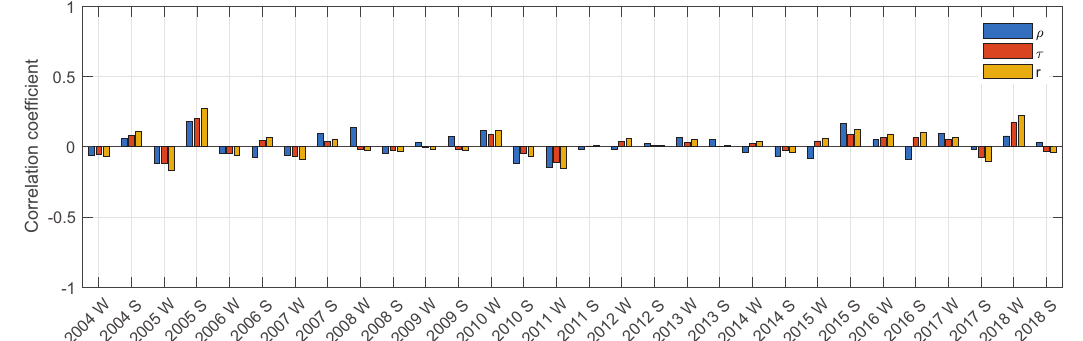
Figure 17. The Pearson ( ρ ), Kendall ( τ ) tau and Spearman rho (r) correlation coefficient between time series of detrended groundwater level and precipitation. W: winter season, S: summer season. What might be the reason for the small